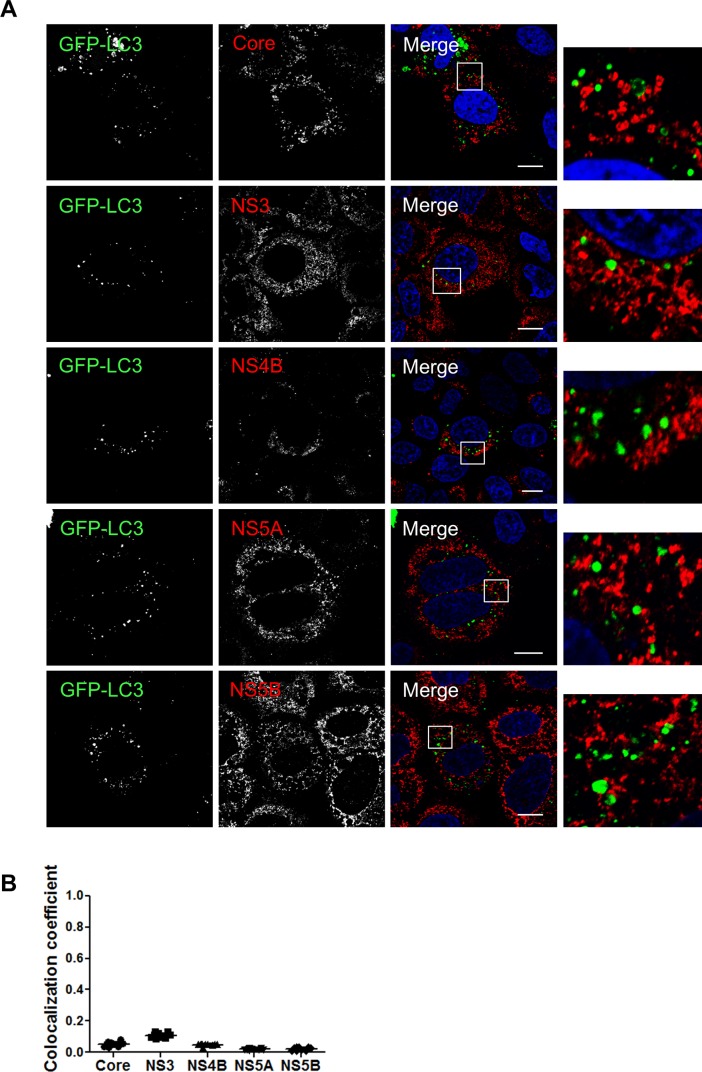
LC3 does not colocalize with HCV proteins.A. Huh7 cells were infected with JFH1 and then transfected with GFP-LC3. Confocal microscopy images displaying subcellular localization of GFP-LC3 and HCV core, NS3, NS4B, NS5A and NS5B are presented. Scale bar, 10μm. B. The values of overlapping fluorescence signal of GFP-LC3 with HCV nonstructural proteins were calculated using Manders’ colocalization coefficient (n = 5 cells, 10 arbitrary positions).